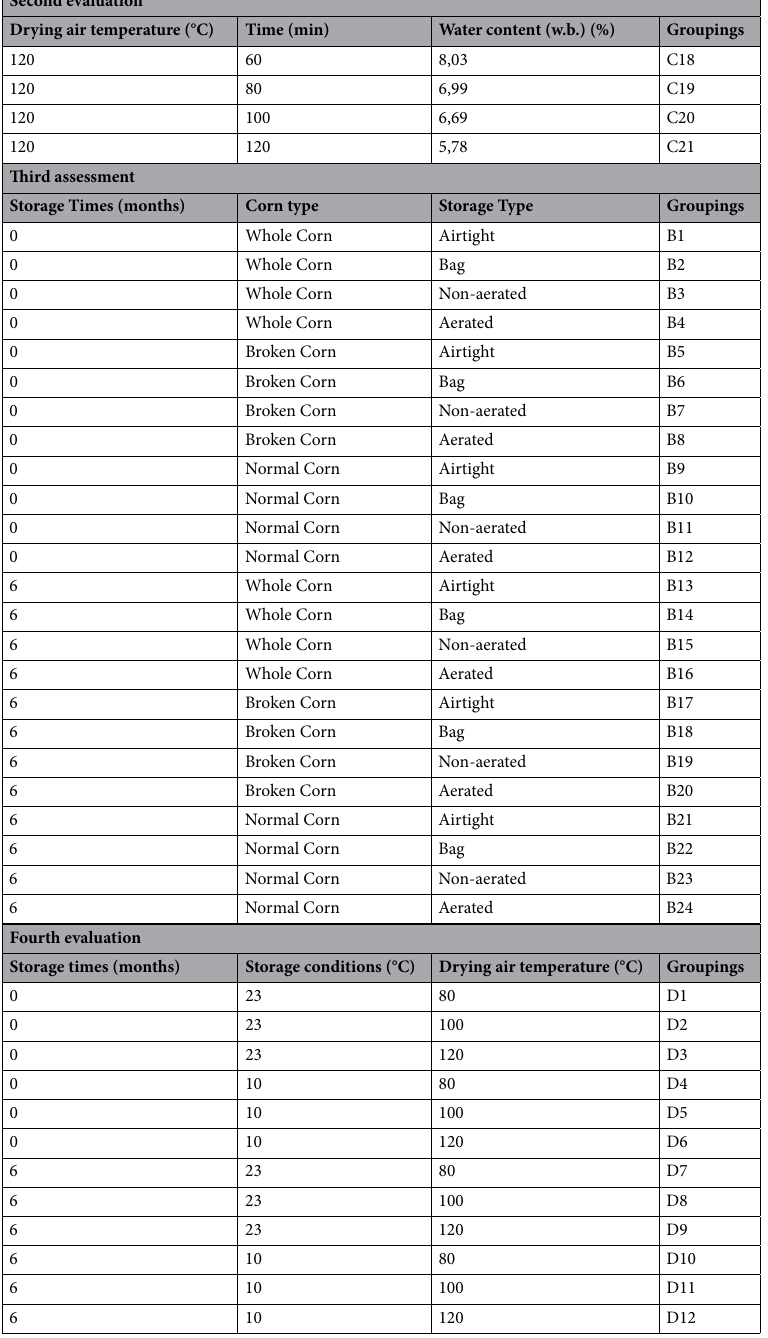
Table 6. Experimental parameters to determine the quality of maize according to different drying air temperatures storage systems and